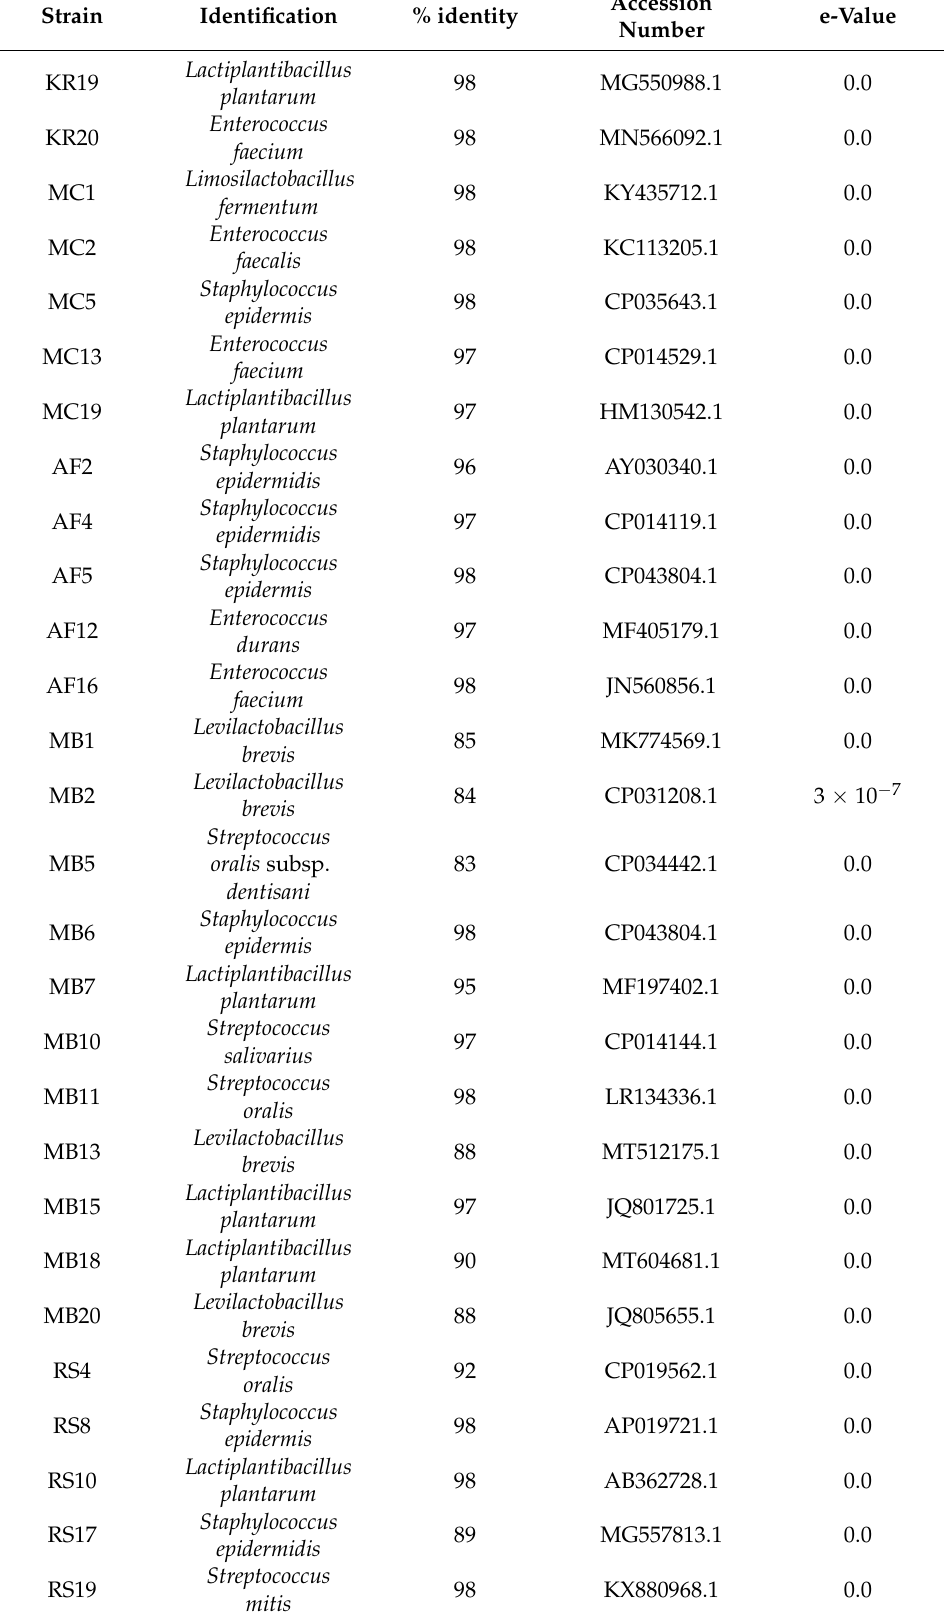
Table 1. 16S rRNA gene sequence identification of selected bacterial human milk